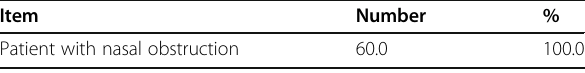
Table 5 Distribution of cases according their nasal obstruction Item